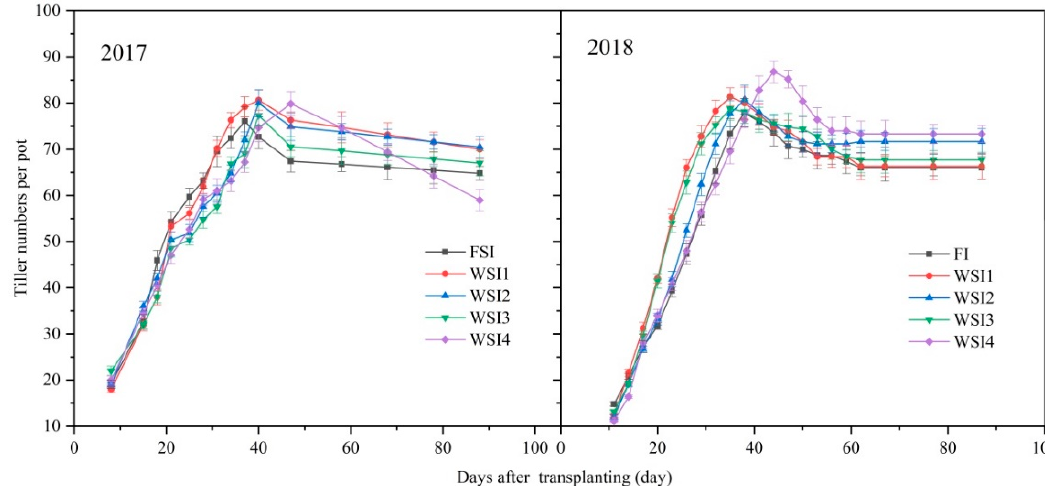
Figure 3. The variation of the tiller numbers per pot in 2017 and 2018.